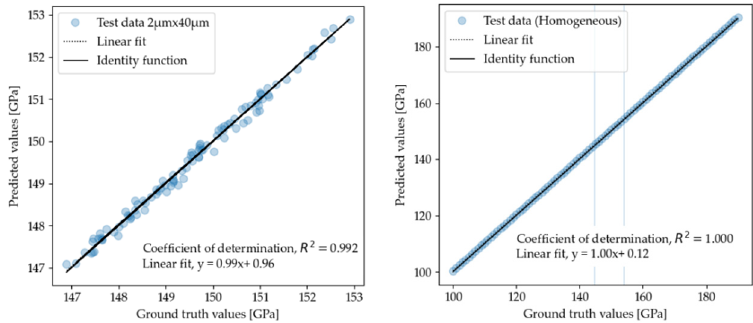
Figure 4. Performance of Model 2 on the test sets specified in Section 2.3.2.